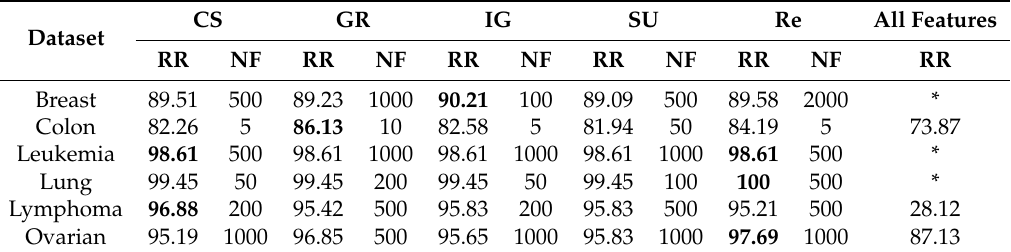
Table 8. Best results of ranking-based feature-selection methods with NN classifier.